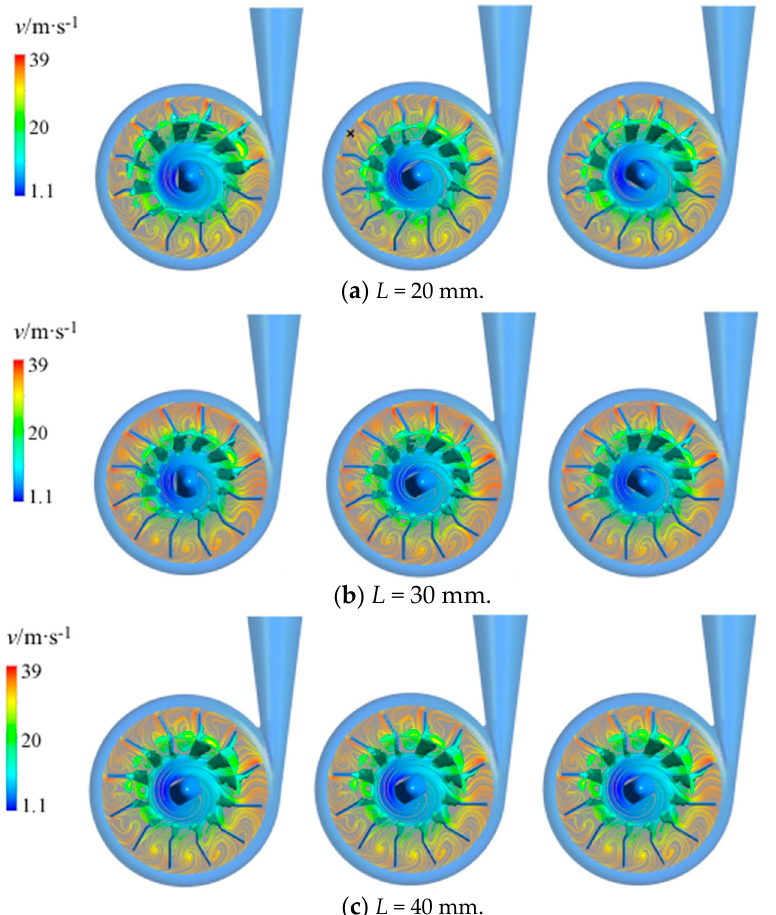
Figure 7. Flow streamline and bubble distribution of the vortex pump impeller under different instants and L values .